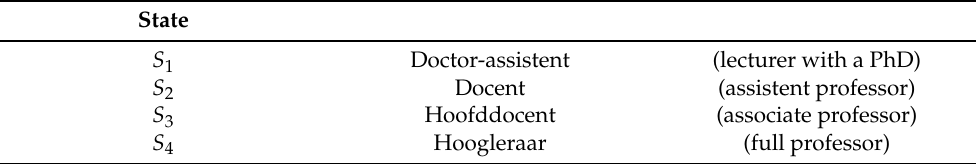
Table 1. Personnel categories in our manpower system.